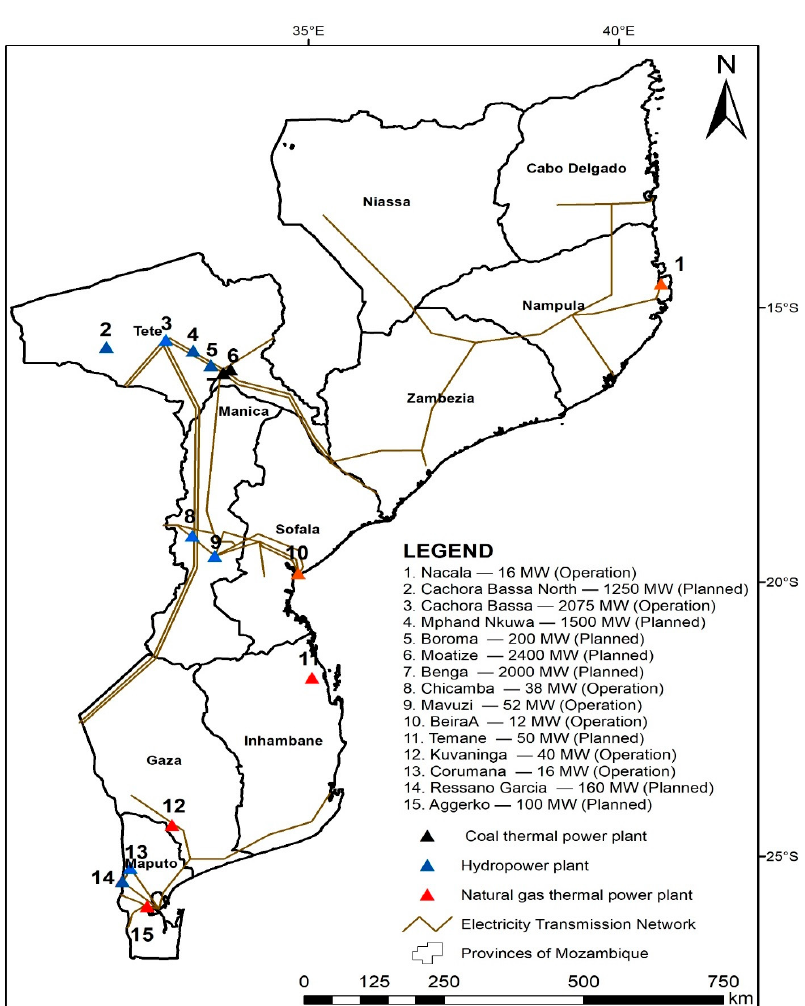
Figure 2. Outline of the three main grid systems in Mozambique with existing or planned large power plants. Source: own illustration with information from [5,7,26].